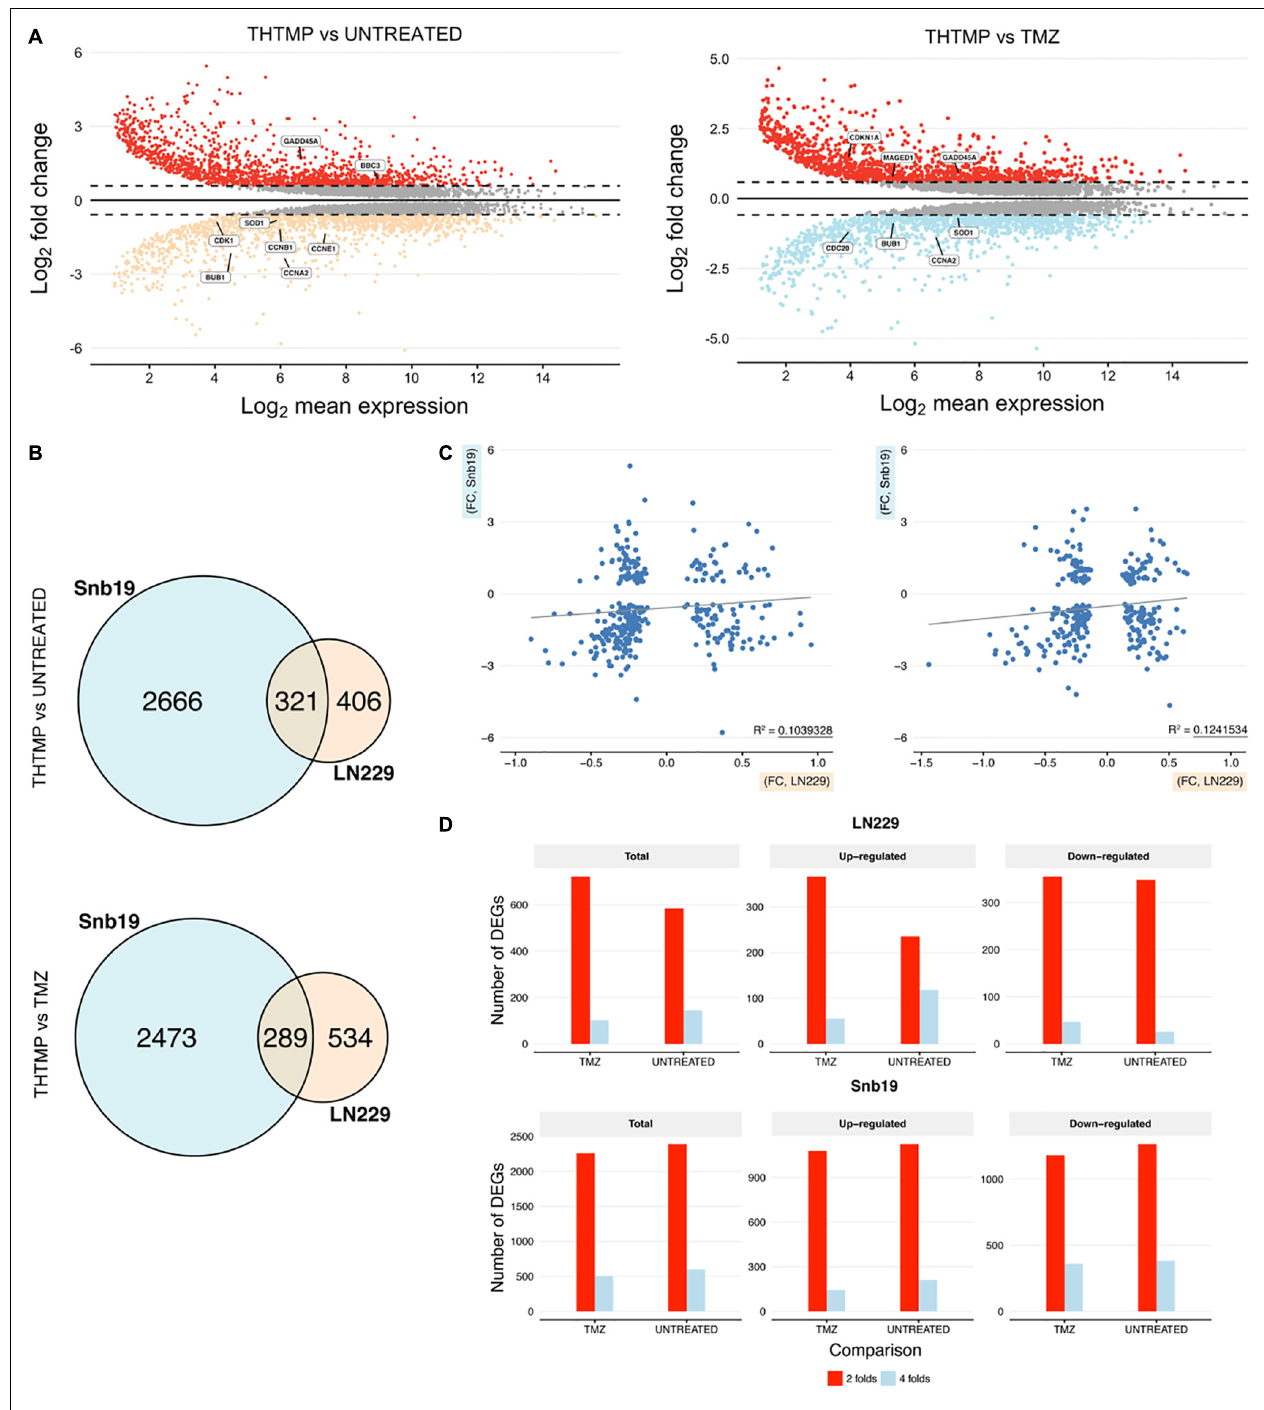
FIGURE 3 | DEGs comparisons on LN229 and Snb19 samples. (A) MA-plot from means and log fold changes. The figure shows differential gene expression from the two inter-group comparisons (THTMP vs. Untreated; THTMP vs. Temozolomide). For MA-plot construction, a gene was considered to be differentially expressed between groups at an absolute log2 fold change > 1.5 or < -1.5 and a q -value of 0.05 (moderated t -test; Benjamini-Hochberg procedure). (B) Overlapping DEGs in LN229 and Snb19 samples compared with positive and negative control at C1 and C2. For each comparison, only genes with a q -value < 0.05 were considered as DEGs. The number of DEGs found at each comparison are indicated. (C) Scatter plots of fold-changes in gene expression levels after treatment of C1 and C2. The R 2 value was calculated for genes with t -test p -values < 0.1. (D) The total number and upregulated/downregulated number of DEGs of both cell lines after treatment.